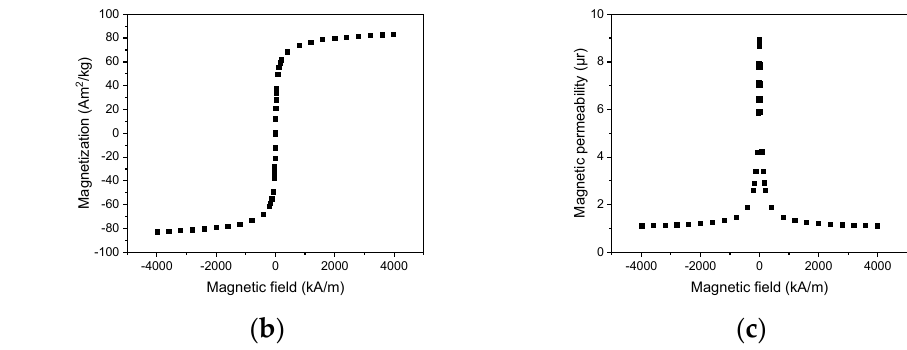
Figure 2. ( a ) X-ray diffractogram of the synthesized iron oxide nanoparticles obtained with a Mo K α source in transmission [33]. Magnetization curves ( b ) and relative magnetic permeability ( c ) obtained with SQUID of the synthesized iron oxide nanoparticles at 300 K.